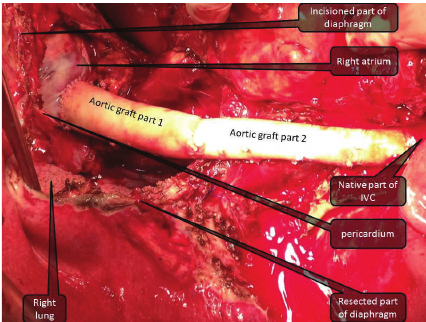
Figure 4: Incised pericardium and total replacement of retrohepatic part of vena cava (from renal vein to right atrium) are seen.